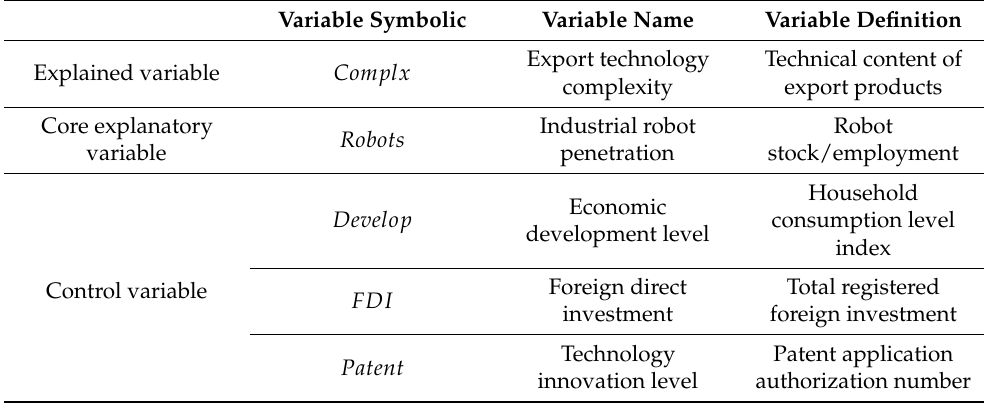
Table 1. Variable